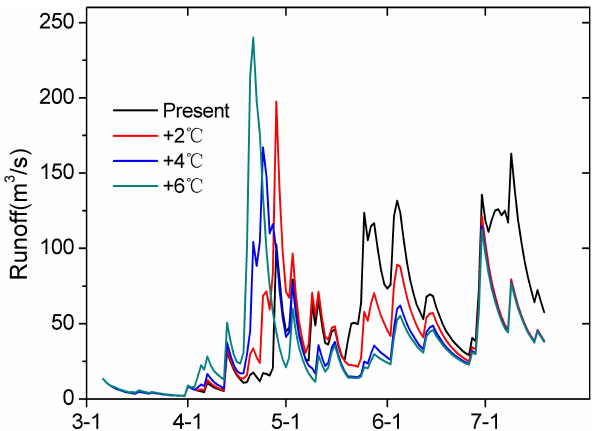
Fig. 15. Responses of snowmelt runoff to air temperature increases, +2 ◦ C, +4 ◦ C, +6 ◦